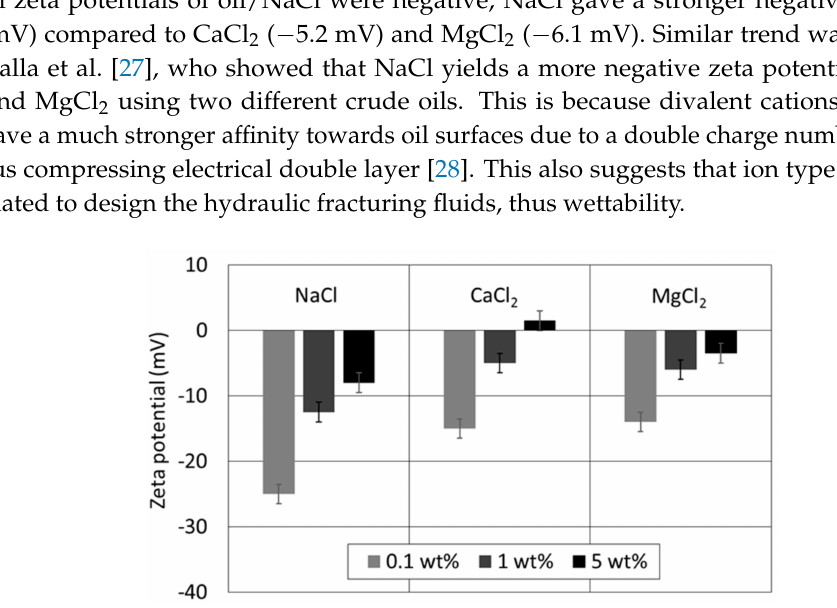
Figure 1. Zeta potential of oil/brine with various ion types and